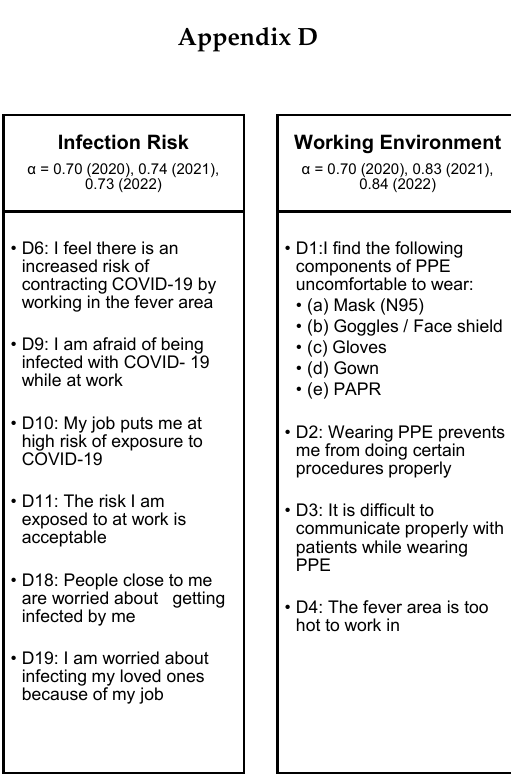
Figure A2. Questions on ED HCWs’ concerns and perceptions were categorised based on content relevance shown below for data analysis with listed factor analysis (Cronbach’s alpha, α ).